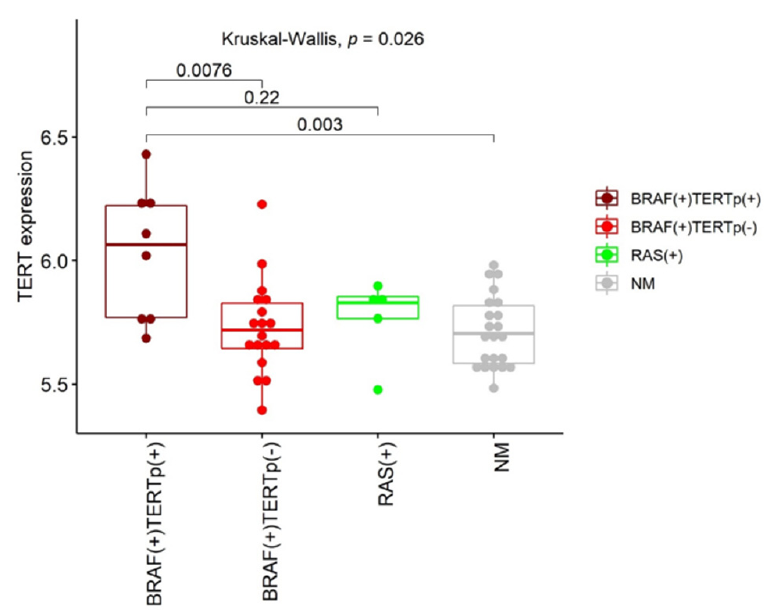
Figure 3. TERT gene expression in PTC sets with di ff erent mutations; RAS( + ) cohort was BRAF( − ) and TERTp( − ). p -values shown on plot were calculated with Kruskal-Wallis and two-tailed Mann-Whitney tests. Table 2. Number of genes significantly deregulated depending on the molecular di ff erentiating factor; M- the presence of BRAF or TERT p or RAS somatic mutation; NM- no somatic mutations within studied genes.